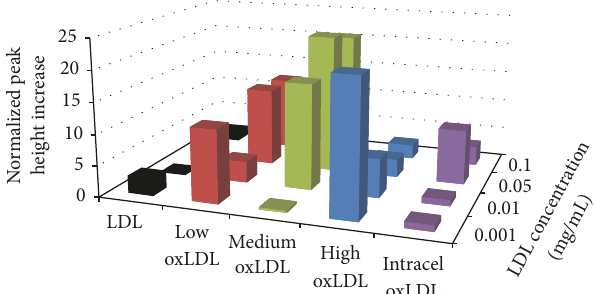
Figure3:AveragemetabolicoxygenconsumptionresponseofRAW 264.7 cells to a 6 min exposure of various LDL. Percent increases were calculated based on the variation from the maximum peak height chance during exposure to the baseline average, prior to exposure. For native LDL at 100 𝜇 g/mL 𝑛 = 4 ; ± 0.28%, 50 𝜇 g/mL 𝑛 = 3 ; ± 0.27%, 10 𝜇 g/mL 𝑛 = 4 ; ± 0.09%, and 1 𝜇 g/mL 𝑛 = 3 ; ± 0.27%. For low oxLDL at 100 𝜇 g/ml 𝑛 = 2 ; ± 1.03%, 50 𝜇 g/ml 𝑛 = 2 ; ± 5.1%, 10 𝜇 g/ml 𝑛 = 3 ; ± 0.56%, and 1 𝜇 g/ml 𝑛 = 3 ; ± 0.33%. For medium oxLDL at 100 𝜇 g/mL 𝑛 = 3 ; ± 1.51%, 50 𝜇 g/mL 𝑛 = 4 ; ± 0.74%, 10 𝜇 g/mL 𝑛 = 3 ; ± 0.004%, and 1 𝜇 g/mL 𝑛 = 3 ; ± 0.42%. For high oxLDL at 100 𝜇 g/mL 𝑛 = 2 ; ± 0.37%, 50 𝜇 g/mL 𝑛 = 3 ; ± 0.09%, 10 𝜇 g/mL 𝑛 = 3 ; ± 0.11%, and 1 𝜇 g/mL 𝑛 = 2 ; ± 0.94%. For Intracel oxLDL at 100 𝜇 g/mL 𝑛 = 4 ; ± 0.16%, 50 𝜇 g/mL 𝑛 = 3 ; ± 0.69%, 10 𝜇 g/mL 𝑛 = 3 ; ± 0.57%, and 1 𝜇 g/mL 𝑛 = 4 ; ±